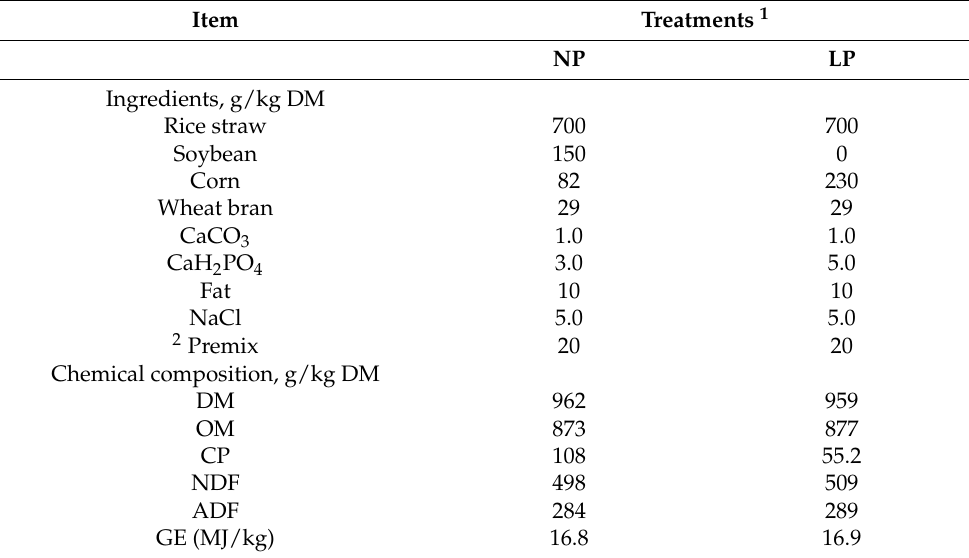
Table 1. Ingredients and chemical composition (g/kg of DM) of experimental diets.